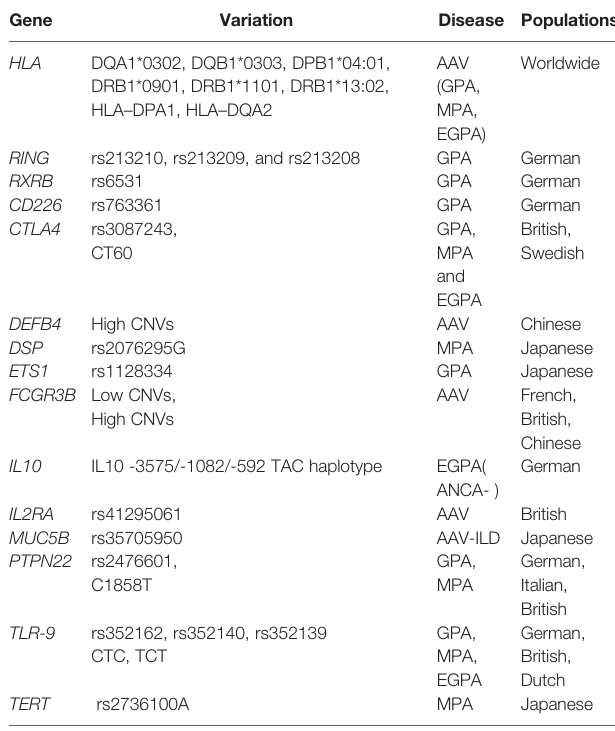
TABLE 3 | Summary of genetic associations with antineutrophil cytoplasmic antibody (ANCA)-associated vasculitis excluding those derived from genome- wide association